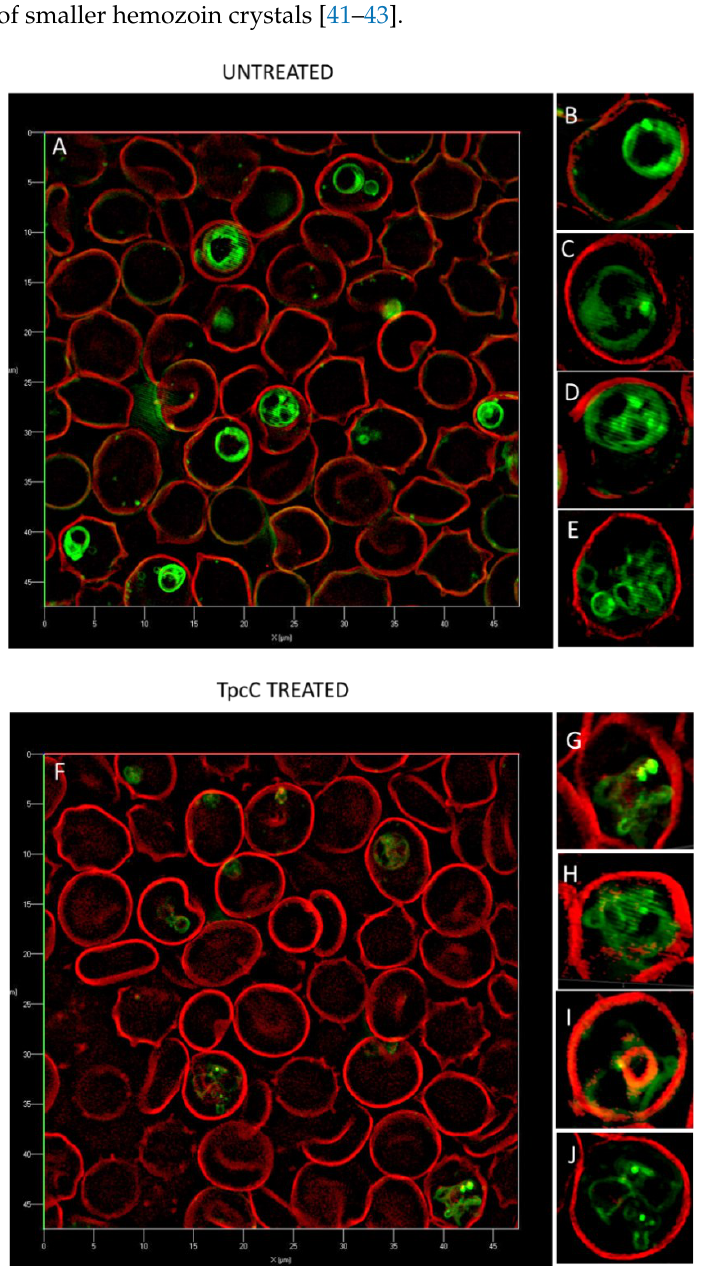
Figure 4. Super-resolution structured illumination fluorescence microscopy images of late intra- erythrocytic stages of P. falciparum D10 stained with trypan blue (red) and neutral lipid binding fluorescent dye LipidTOX (green). The large panels are compiled images from super position of both dye images, with four selected enlarged infected cell images are shown on the right. Images ( A – E ) show the control cultures (no peptide added) and images ( F – J ) show trophozoite stage cultures treated with TpcC after 5 h in culture.